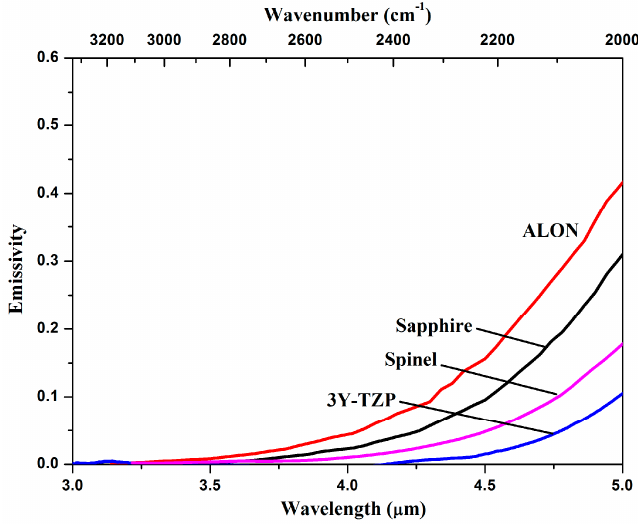
Figure 9. Comparison of the calculated emissivity of ALON, sapphire, spinel (previously reported [29]), and the present 3Y-TZP sample (2.0 mm thick).